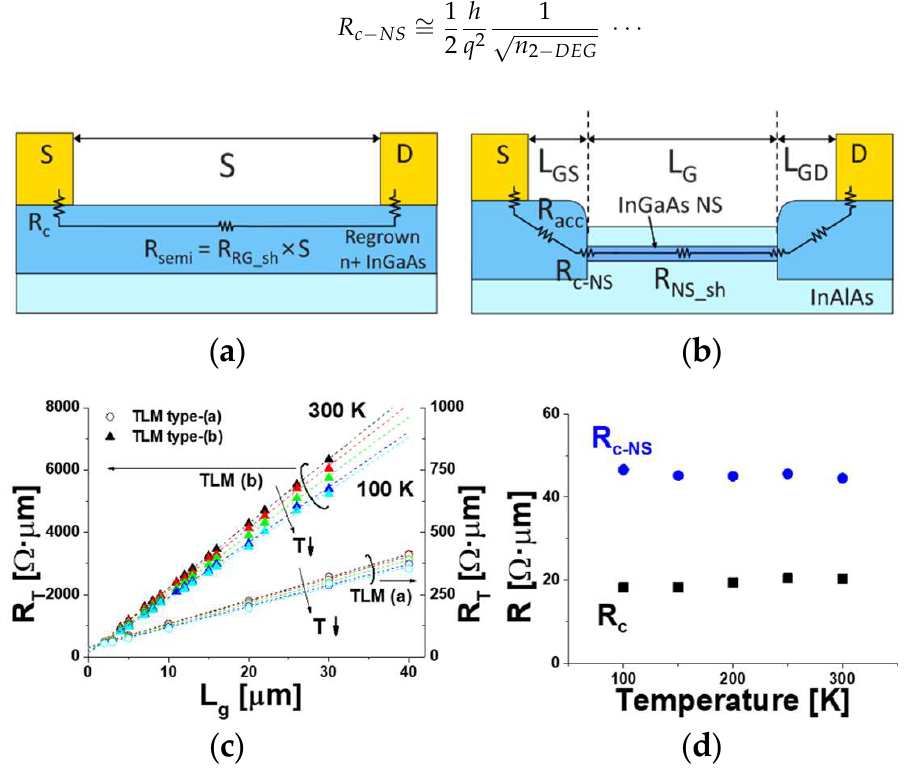
Figure 4. Two TLM structures for ( a ) regrown n+ In 0.53 Ga 0.47 As and ( b ) single-NS, ( c ) the measured total resistance for both TLM structures and ( d ) temperature dependence of the extracted R c and R c-NS .